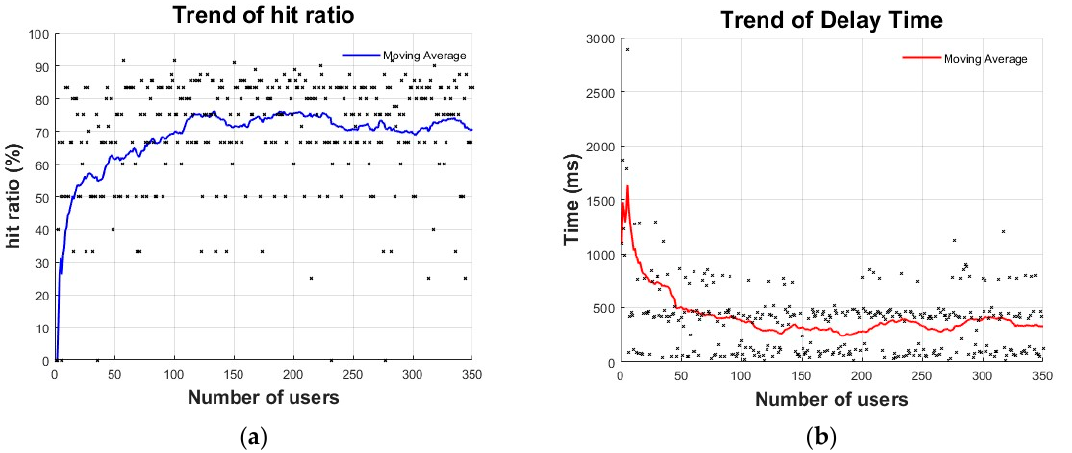
Figure 11. Average content request results of the connected users of the proposed method: ( a ) hit ratio; ( b ) total latency.